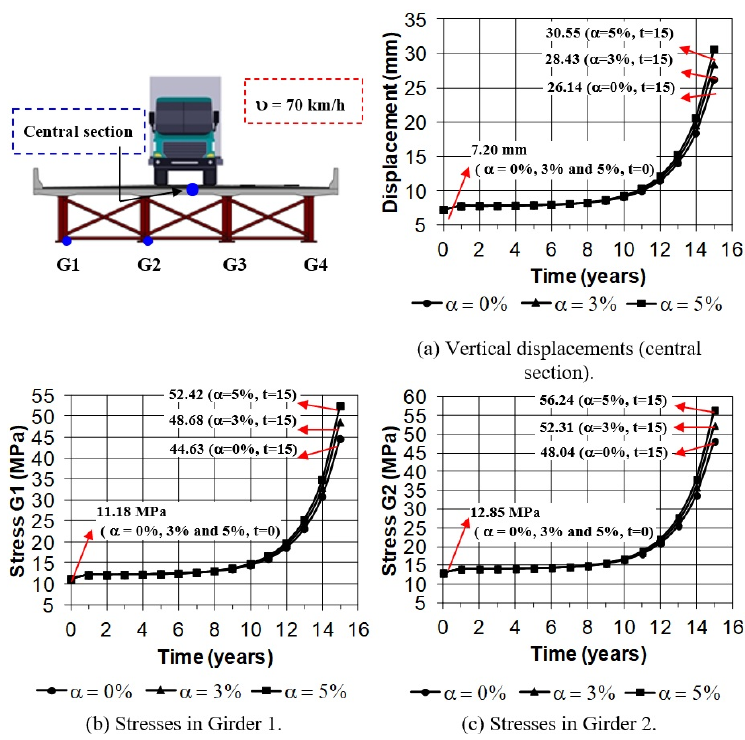
Figure 13. Pavement progressive deterioration effect: υ = 70 km/h (traffic central